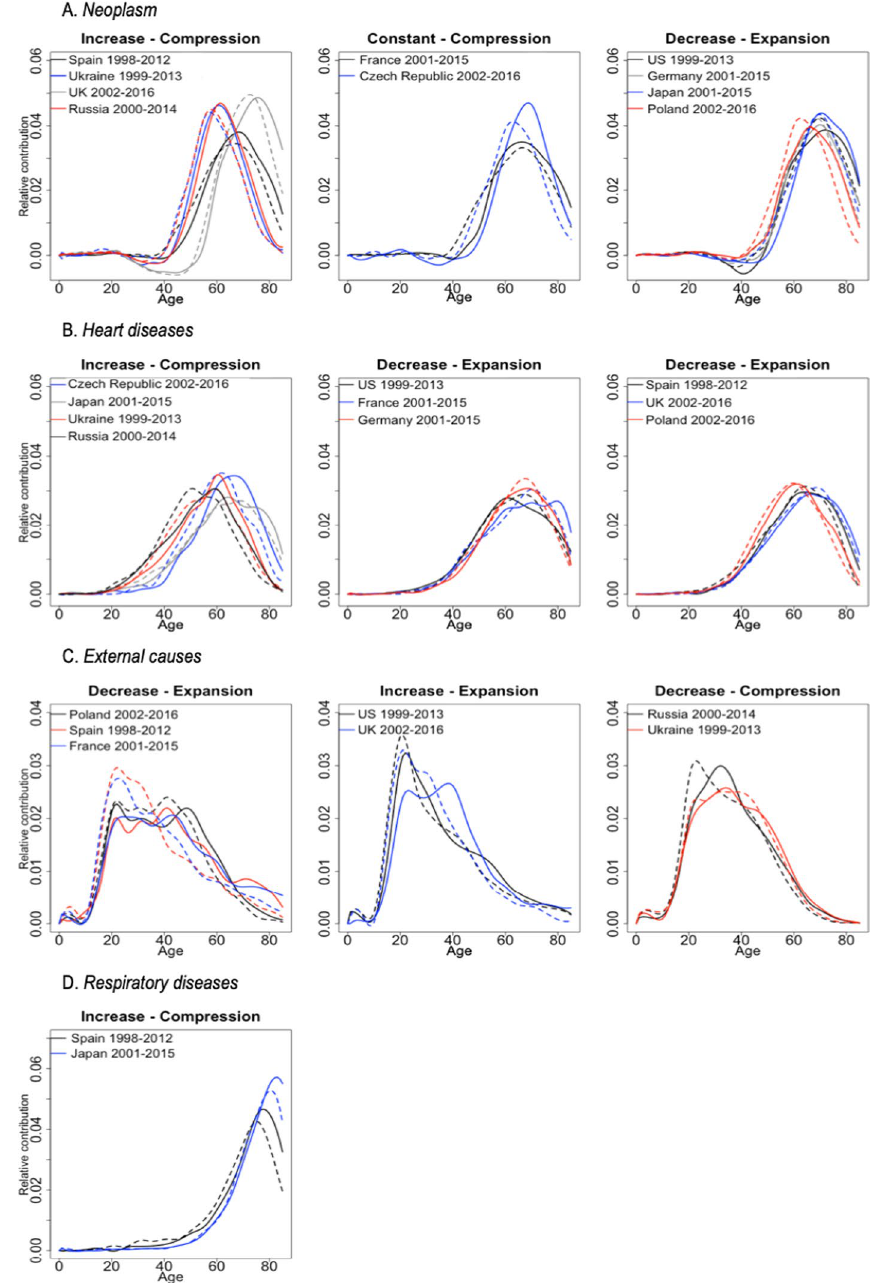
Fig. 6 Country-specific relative age-specific contributions to the sex gap in life expectancy at the beginning (dashed line) and at the end of the observation period (solid line), for each main cause of death. Increase (decrease) denotes increasing (decreasing) relative cause-specific contributions to the overall sex gap (i.e.,